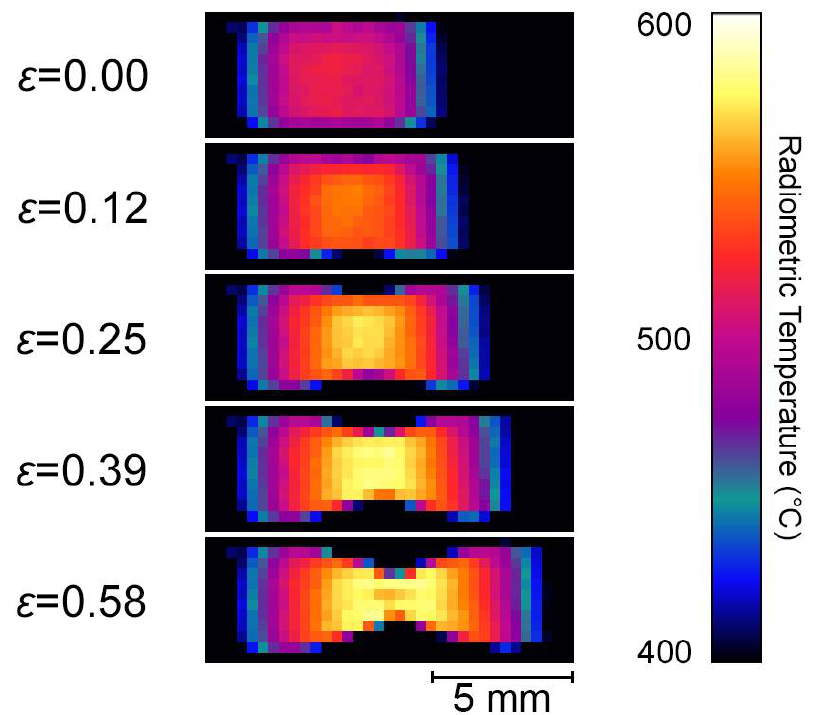
Figure 6. Full-field radiometric temperature evolution caused by adiabatic heating in a commer- cially pure titanium specimen deformed in tension at strain rate of 1600 s −1 at different levels of engineering strain.